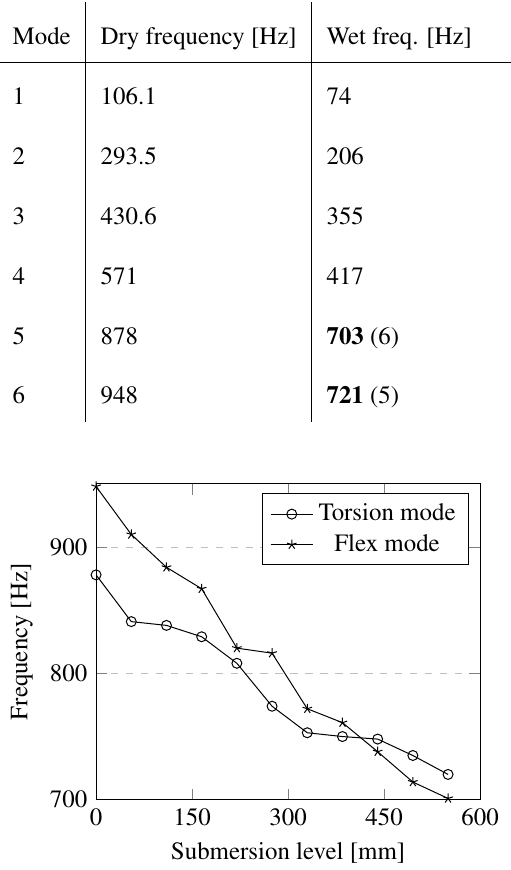
Table 1. Experimental results (bold values of wet frequency indicates change between flex and twist mode)